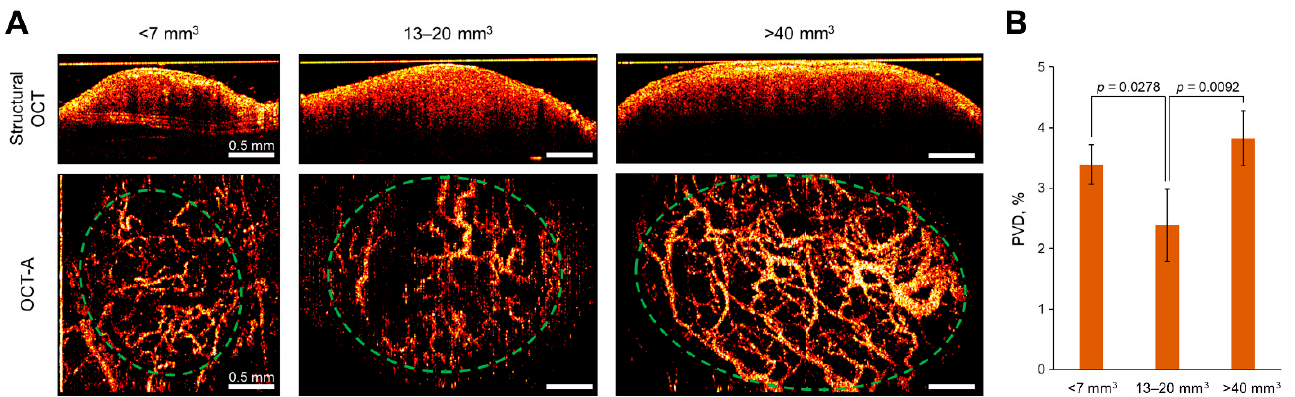
Figure 10. In vivo assessment of tumor microvascular network using OCT-A. ( A ) Representative structural OCT and OCT-A images of tumors. Scale bar = 0.5 mm. Tumors are shown by dashed circles. ( B ) Perfused vessel density in the tumors. Mean ± SD, n = 3–5. p -values are indicated on the diagram.